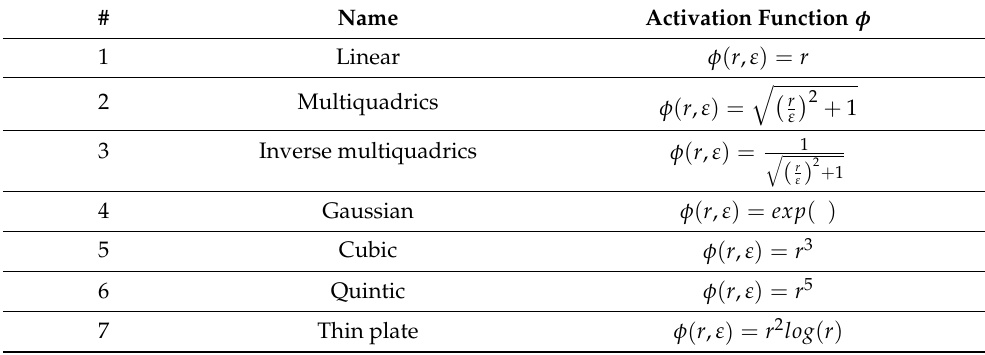
Table 4. Activation functions used in